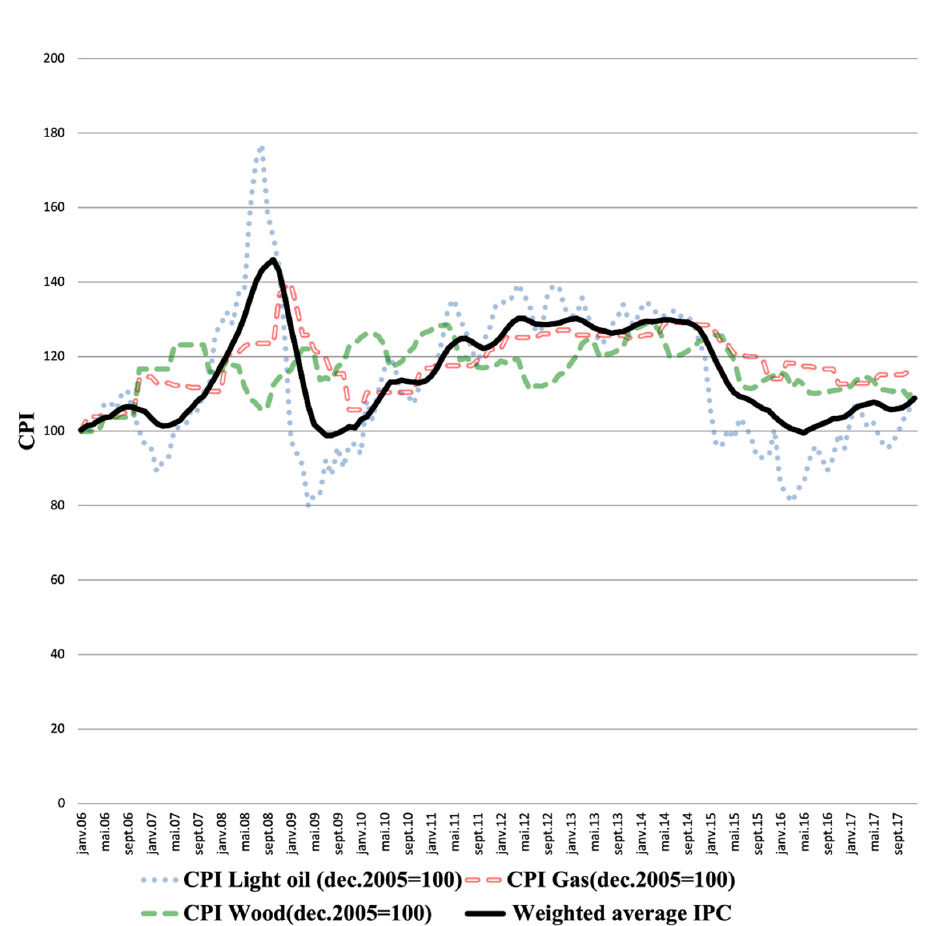
Figure A3. Monthly CPI and energy price index. Note: CPI, Consumer Price Index. Sources: [41,42], own calculations.